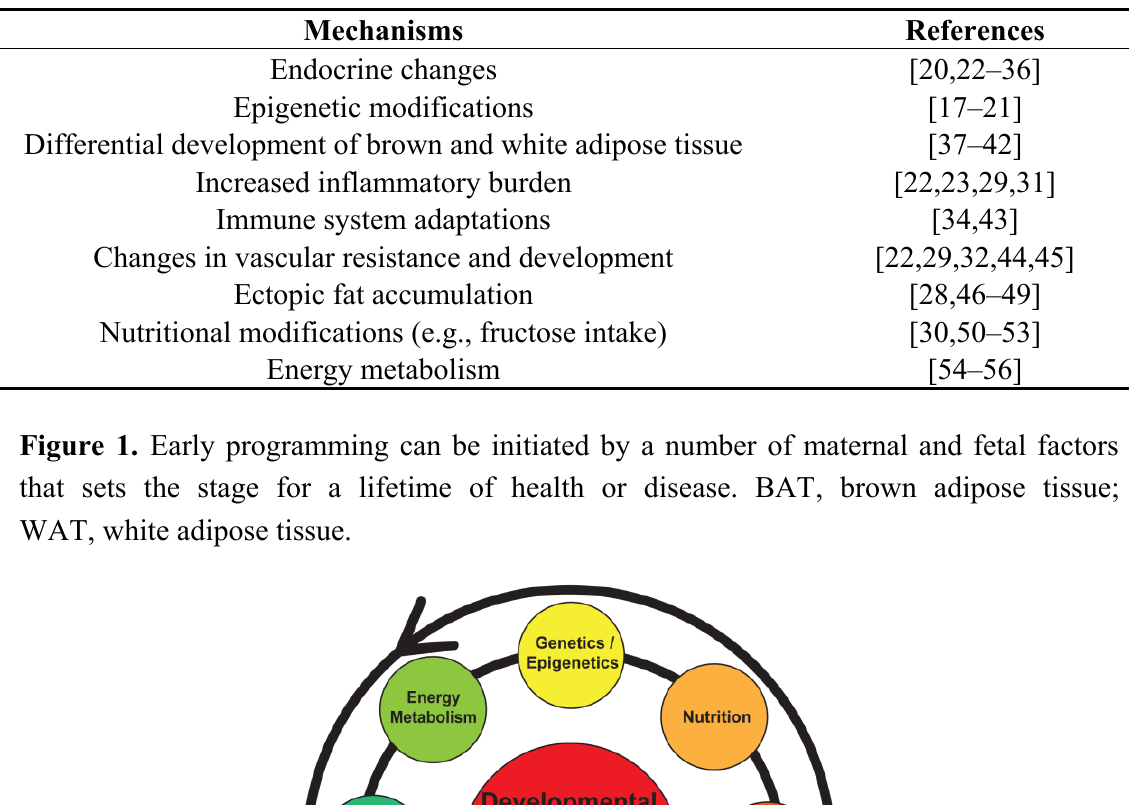
Table 1. Potential mechanisms by which maternal obesity can impact fetal development and future health.